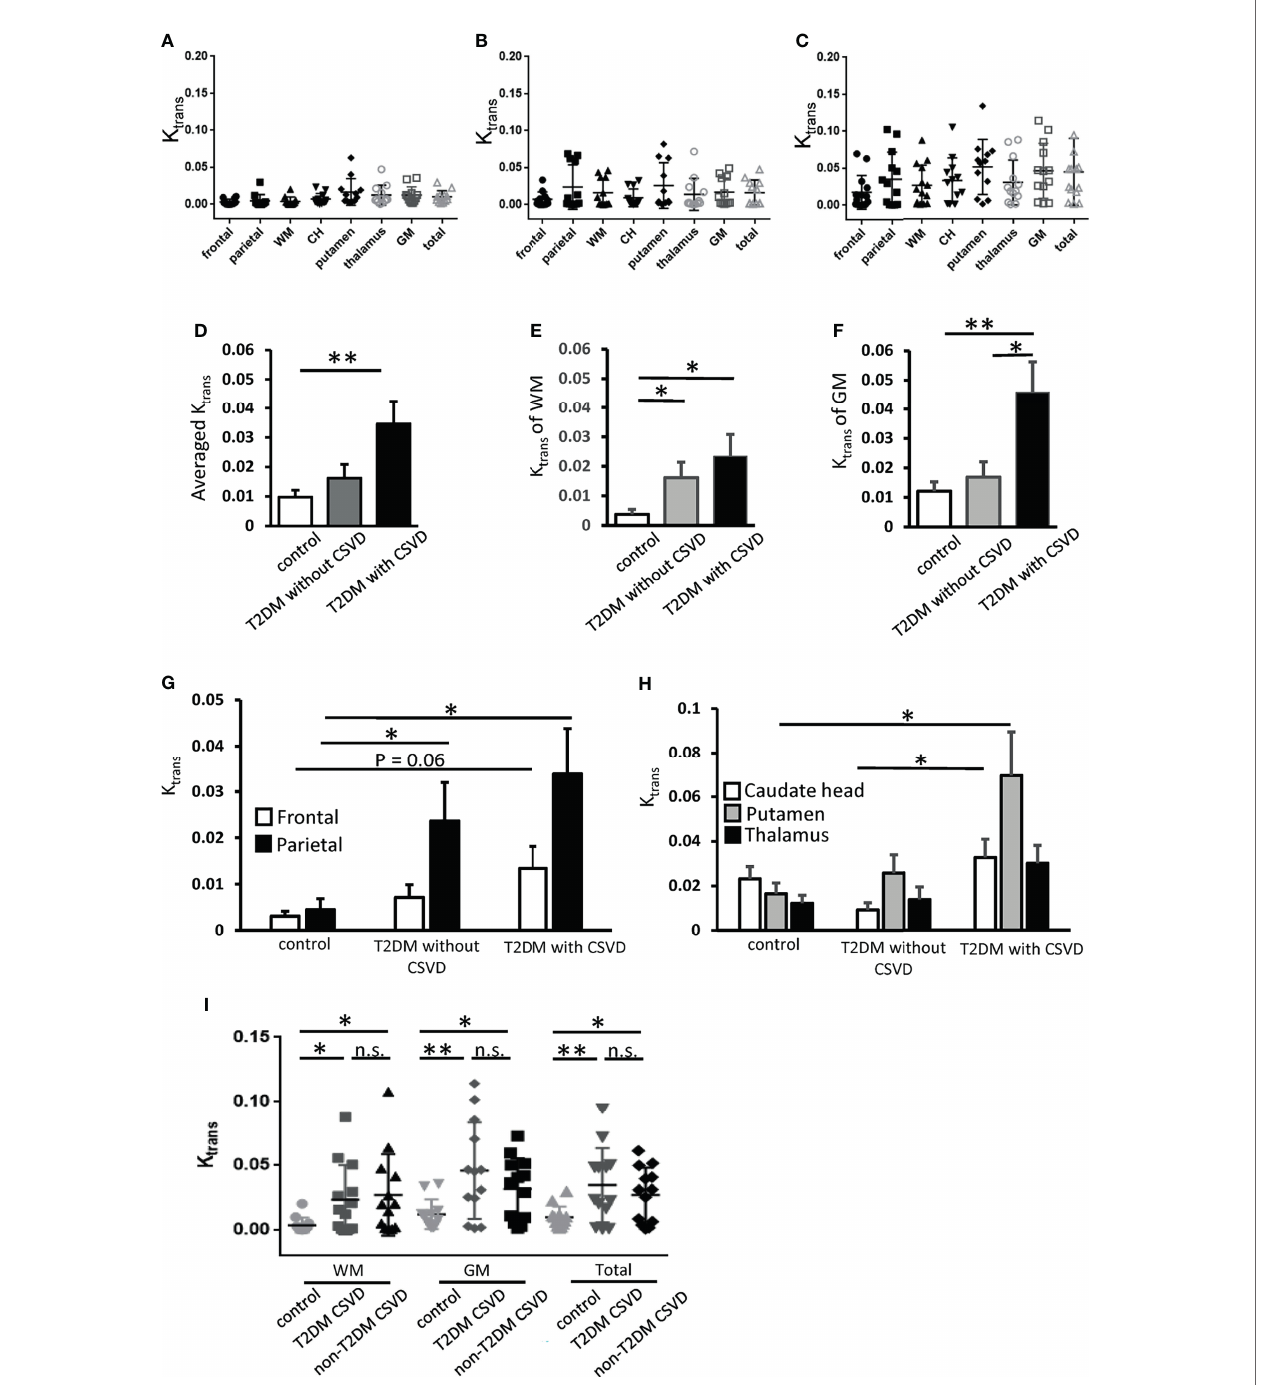
FIGURE 3 | K trans of each cerebral area in the control, T2DM, and T2DM with CSVD groups. (A – C) K trans of each area in the control ( N = 12) (A) , T2DM without CSVD ( N = 12) (B) , and T2DM with CSVD groups ( N = 13) (C) . (D – F) Comparisons of the averaged total K trans (D) , K trans of the WM (E) , and K trans of the GM (F) among control, T2DM without CSVD, and T2DM with CSVD groups. (G, H) Comparisons of K trans in the frontal and parietal WM (G) and K trans in the caudate head (CH), putamen, and thalamus (H) between control, T2DM without CSVD, and T2DM with CSVD groups. (I) Comparisons of K trans in the WM, GM, and total K trans between the control group, CSVD patients with T2DM, and CSVD patients without T2DM. Unpaired t -test. NS, no signi fi cance; * p < 0.05; ** p < 0.01. WM, white matter; GM, gray matter; CH, caudate head; T2DM, type 2 diabetes mellitus; CSVD, cerebral small vessel